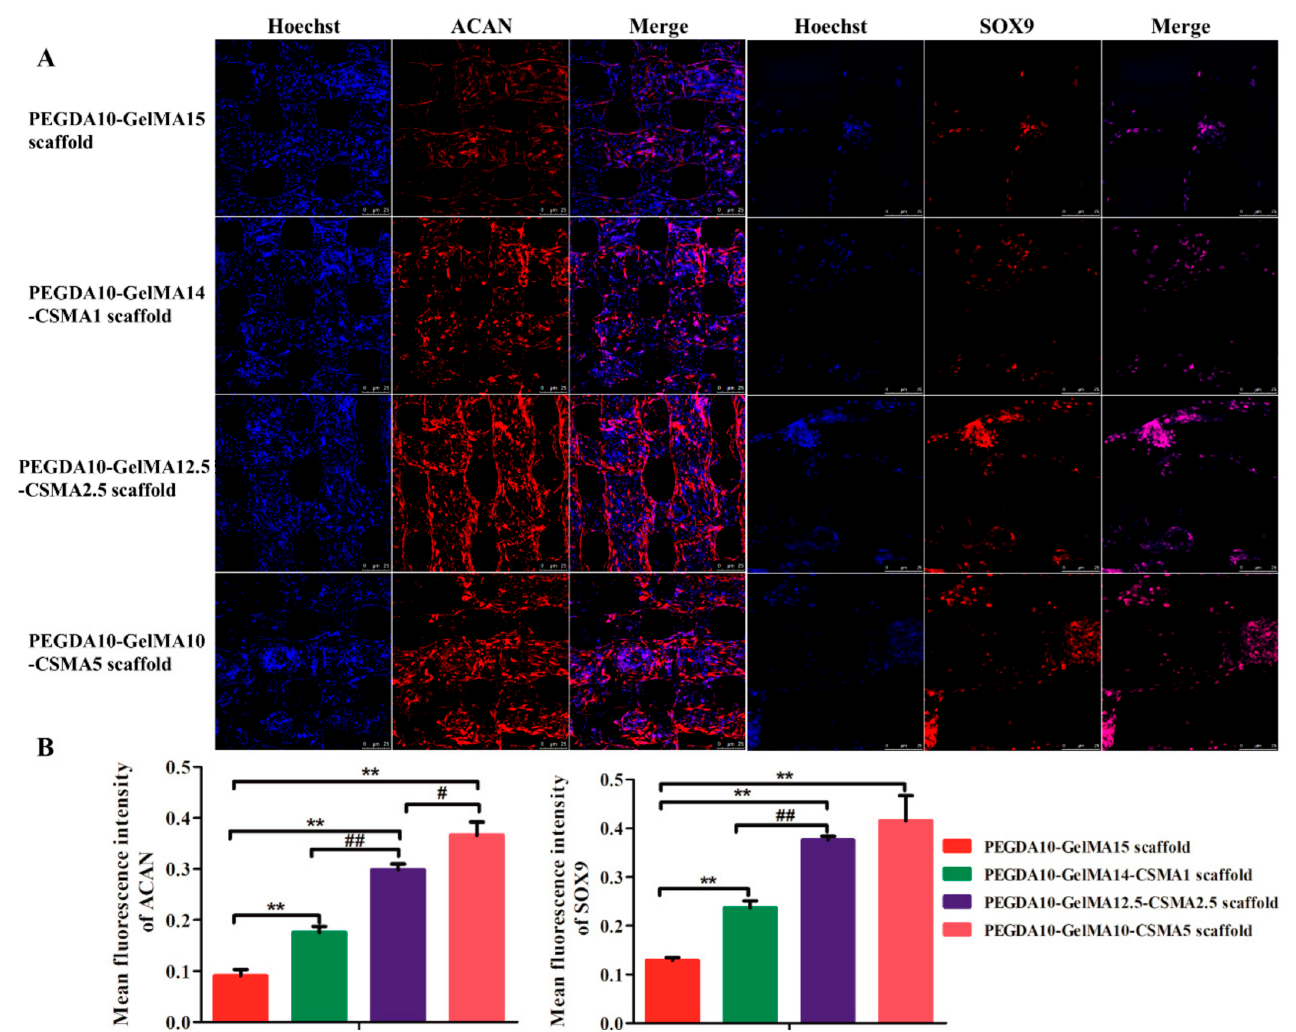
Figure 6. ACAN and SOX9 production analysis by immunofluorescence. ( A ) Immunofluorescence staining images and ( B ) fluorescence intensity of ACAN and SOX9 secreted by BMSCs on four scaffolds on day 14. The nuclei are stained blue. The proteins ACAN and SOX9 are stained red. The scale bar is 25 µ m ( n = 3; ** p < 0.01, ## p < 0.01, # p <